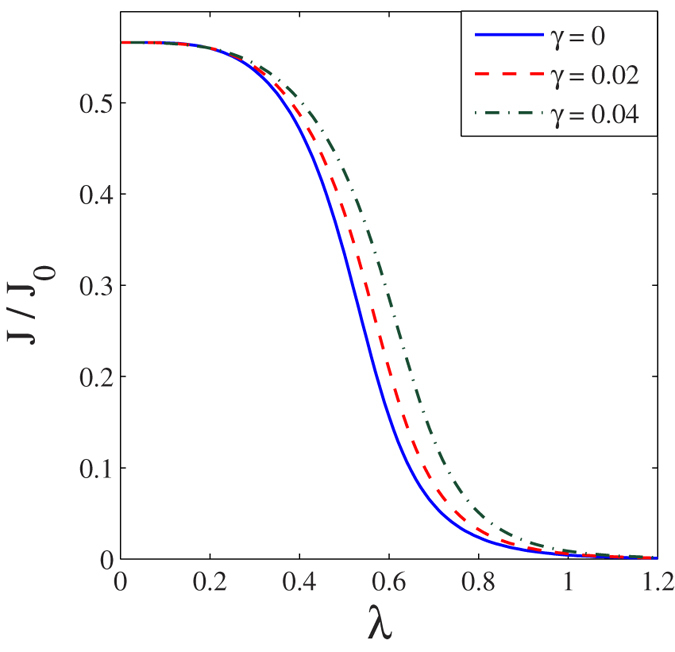
The dimensionless current as a function of λ with eVB = 0.5.